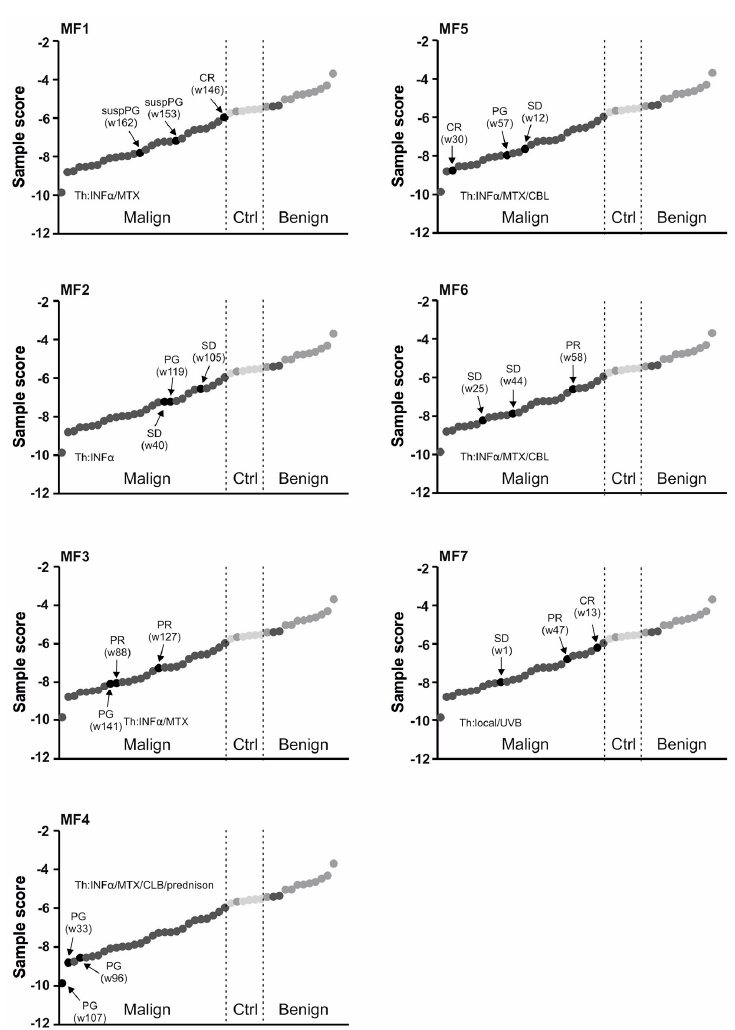
Figure 4. Plasma 3-miR-score in MF patients. Clinical data (MF1-7) are indicated, including the therapy (Th) and response (see Table 1). For each sample the time in weeks (w) is calculated from the diagnosis. Each sample represented by a circle: empty healthy, grey BL, dark CTCL. Dashed lines separate diagnostic subgroups. Arrows indicate consecutive samples of a patient whose ID is placed on top.